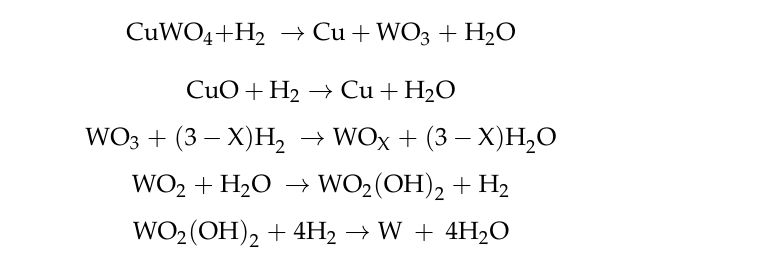
as heterogeneous nucleation while reducing the deposited nucleation of volatile WO 2 (OH) 2 , resulting in a smaller tungsten particle size. The possible equation is as follows [32–34].